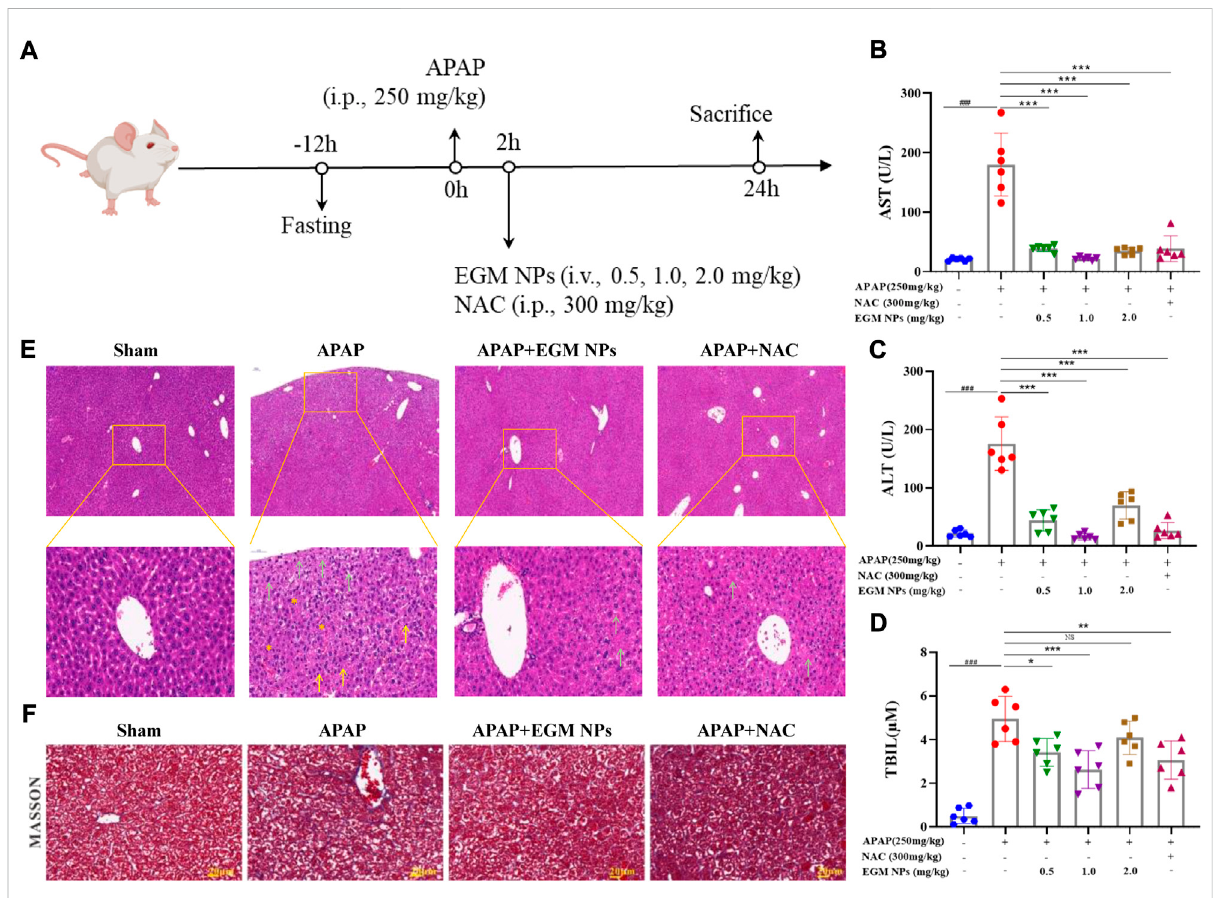
FIGURE 3 Therapeutic effects of EGM NPs on APAP-induced liver injury. (A) Schematic illustration of the establishment and treatment schedule of APAP- induced liver injury mice. Serum levels of ALT (B) , AST (C) and TBIL (D) in normal mice or APAP-induced liver injury mice at 24 h after different treatments. (E) HE staining of liver tissues and their enlarged images from each group. (F) Masson-trichrome staining of liver tissues from each group. Scale bar: 20 μ m. Data represent means ± S.D. from six independent replicates. (* p < 0.05, ** p < 0.01, *** p < 0.001 vs . APAP group; ### p < 0.001 vs . Sham